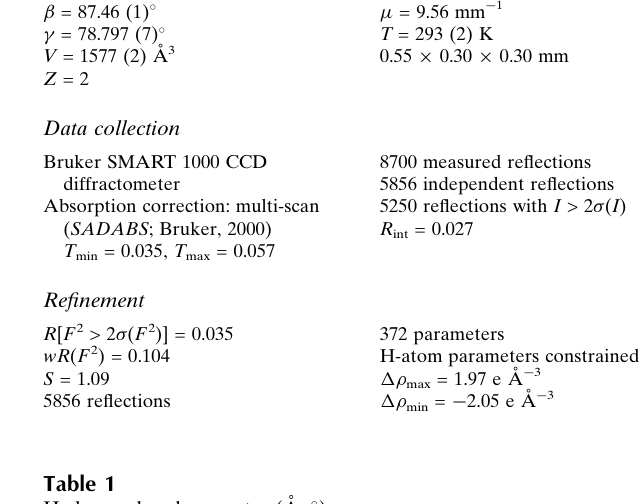
Hydrogen-bond geometry (A˚ , (cid:2)